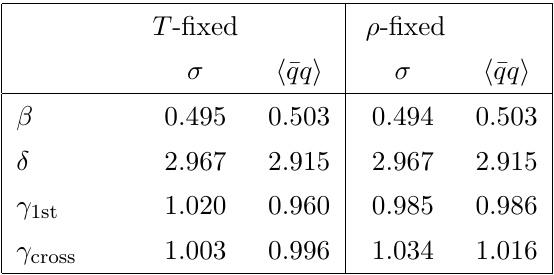
Table 1 . Critical